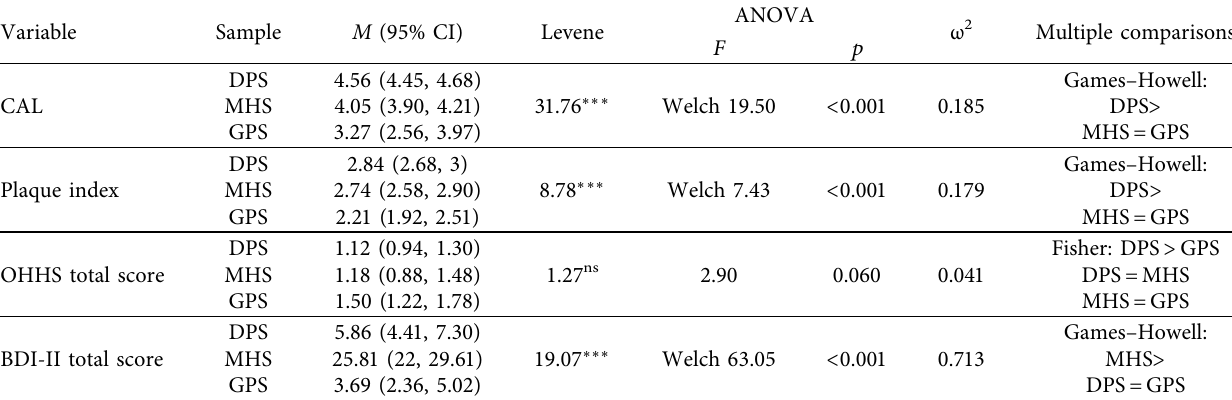
Table 4: One-way analysis of variance for independent groups and multiple pairwise comparisons of means.